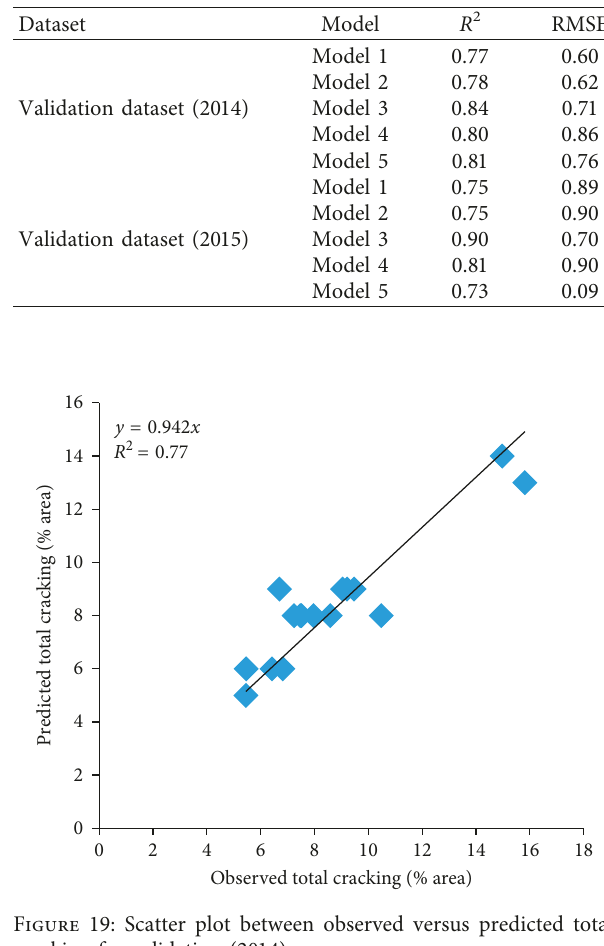
Figure 18: Scatter plot between observed versus predicted roughness for training. Table 7: Results of the proposed models for validation dataset.